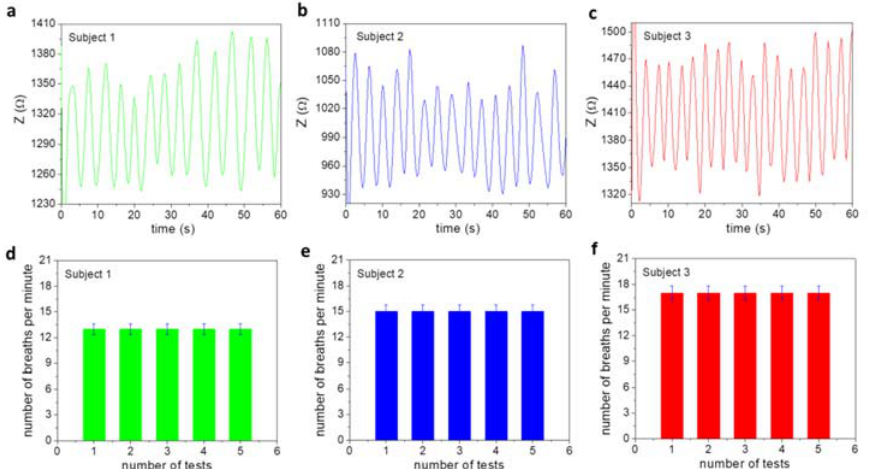
Figure 2. Normal breathing patterns of three subjects of ages ( a ) 30, ( b ) 36, and ( c ) 42 years old. ( d – f ) Tests were repeated five times and showed consistent and reproducible results in number of breaths per minute for each subject.